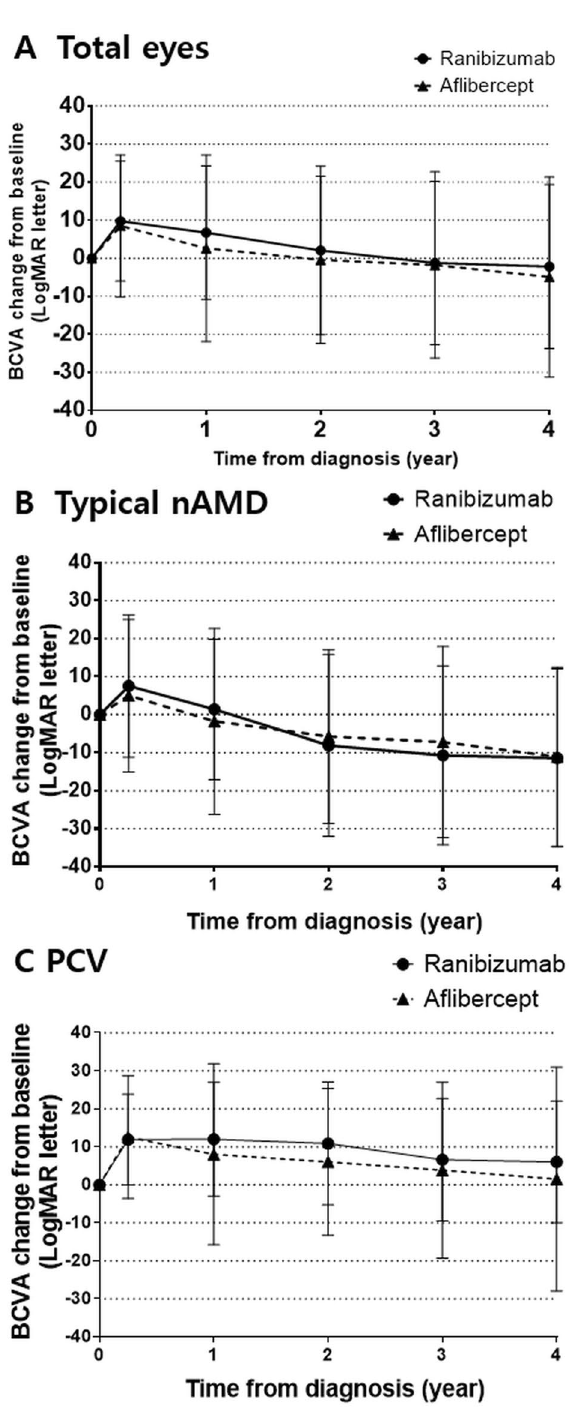
Figure 2. Mean change in visual acuity from baseline at each time point during the 4-year follow-up period. ( A ) Total eyes, ( B ) typical neovascular age-related macular degeneration subgroup, and ( C ) polypoidal choroidal vasculopathy